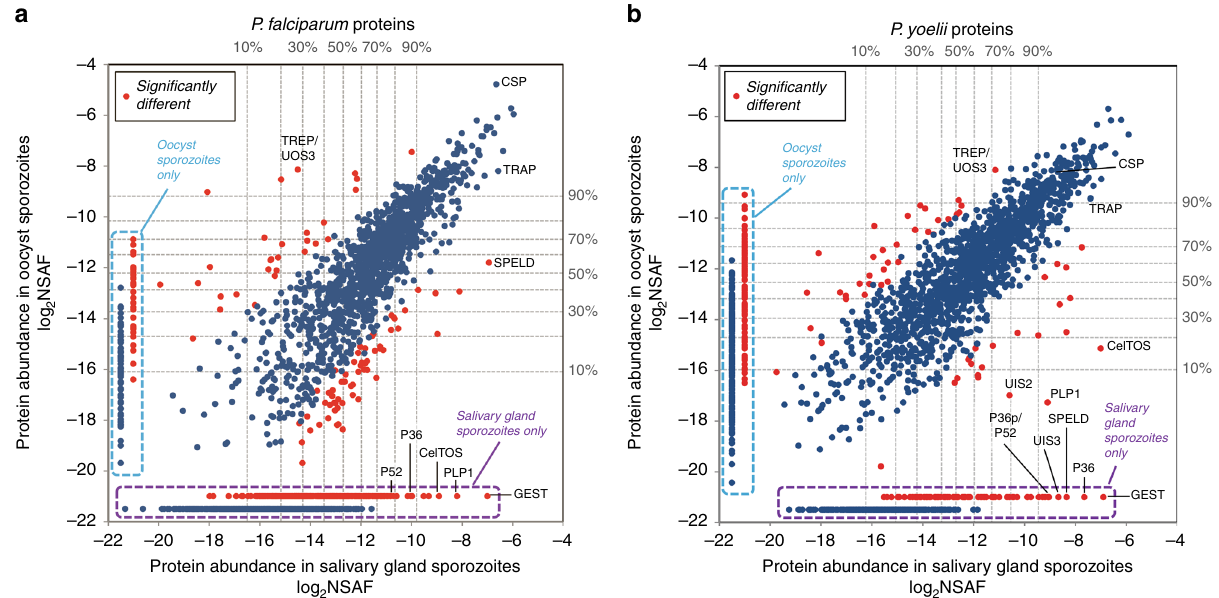
Fig. 2 Comparative total proteomics of oocyst sporozoites and salivary gland sporozoites. Total protein from puri fi ed a P. falciparum or b P. yoelii sporozoites isolated from oocysts or salivary glands was separated by a gradient SDS-PAGE, digested with trypsin, extracted, and analyzed by LC – MS. Protein abundance is presented as the log 2 of the normalized spectral abundance factor (NSAF), a label-free quanti fi cation approach that enables comparison of relative protein abundance within and between samples. Proteins with statistically signi fi cant differences in abundance are noted with red dots, and expression percentile thresholds are provided by dashed lines. Proteins that were only detected in oocyst sporozoites or salivary gland sporozoites are boxed in light blue and purple dashed lines, respectively. Notable proteins are